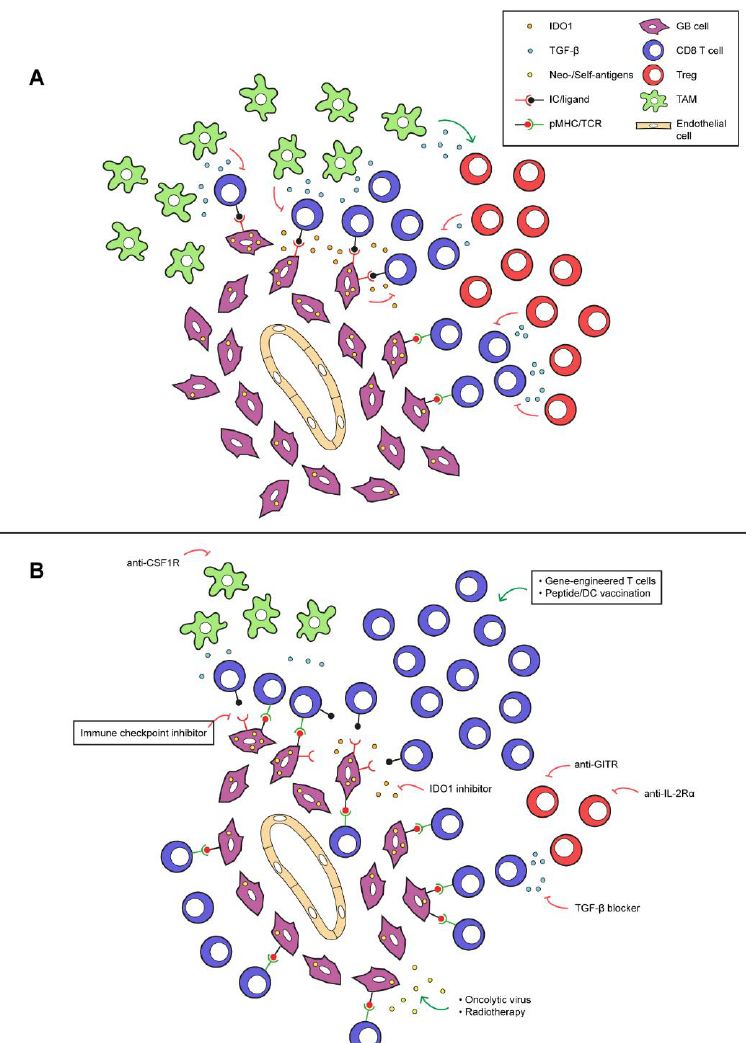
Figure 1. Exemplary immune-suppressive mechanisms in glioblastoma, and therapeutic interventions to sensitize glioblastoma for T cell treatments. ( A ) Tumor-associated macrophages (TAMs) and regulatory T cells (Tregs) release immunosuppressive mediators in the glioblastoma microenvironment, such as TGF- β and IL -10 (the latter not depicted). Local production of indoleamine 2,3- dioxygenase (IDO) or tryptophan-2,3-dioxygenase (TDO) by glioblastoma cells depletes tryptophan from the tumor micro-environment, having an adverse effect on the function of CD8 T cells. Also, the immune checkpoint, PD-L1, expressed on glioblastoma cells can engage with PD-1+ T cells to suppress their effector function. ( B ) Monoclonal antibodies directed against glucocorticoid-induced TNFR related protein (GITR) and IL- 2 receptor α (IL - 2Rα) may specifically deplete intratumoral Tregs. Immunosuppressive effects exerted by TGF- β can be abolished by small molecule inhibitors, such as galunisertib. IDO and TDO inhibitors (the latter not depicted) may restore tryptophan levels in the micro-environment, causing re-activation of CD8 T cells. TAM-induced immunosuppression may be counteracted using inhibitors against colony-stimulation factor 1 (CSF1) or its receptor. Oncolytic virotherapy and radiotherapy may cause increased release of antigens, which in turn may result in enhanced numbers and activation of intratumoral CD8 T cells. When (one or several of) these interventions are combined with vaccines, immune checkpoint inhibitors (ICIs) or adoptive transfer of effector lymphocytes, this may significantly improve the recruitment and/or activation state of glioblastoma-specific CD8 T cells and lead to restoration of the efficacy of these T cell treatments in